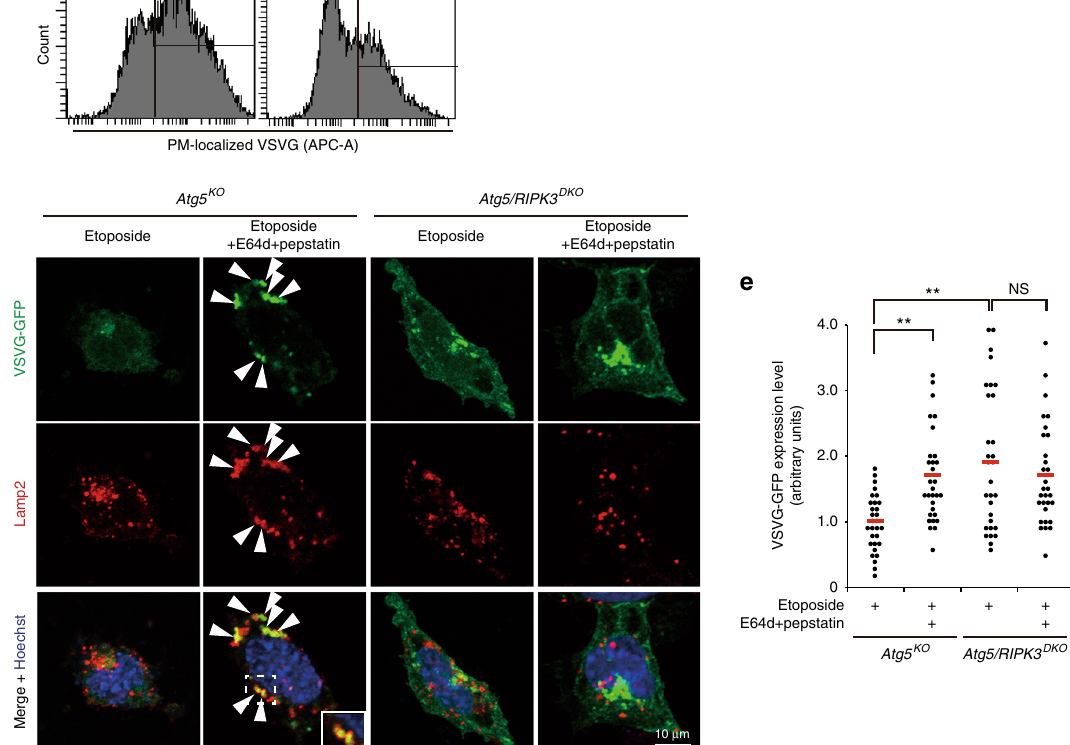
(10 µgmL − 1 ), and pepstatin (10 µgmL − 1 ) at the restrictive temperature for VSVG – GFP (40 °C) for 12h. Cells were then shifted to the permissive temperature (32 °C), and fi xed at the indicated times. Golgi and lysosomes were counterstained with an anti-GS28 and anti-Lamp2 antibody, respectively. Fluorescence intensity (intensity ×area) per cell was calculated using Image J software. In the integrin alpha5 traf fi cking assay, MEFs were treated with or without etoposide (10